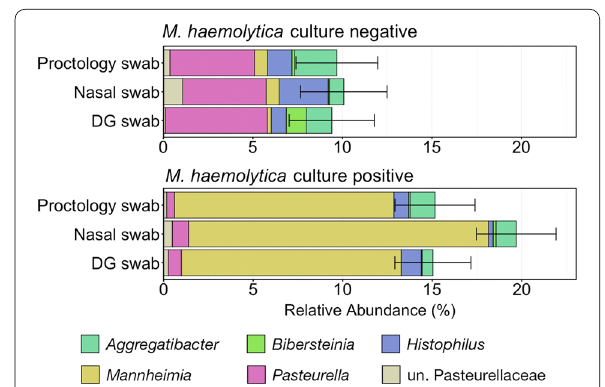
Fig. 10 Bar plot showing the relative abundances among all classified taxa for five Pasteurellaceae genera and unassigned Pasteurellaceae ASVs within M. haemolytica culture-negative and culture-positive animals, as collected with DG swabs, nasal swabs, or proctology swabs. Error bars demonstrate the standard error of the mean relative abundance of Pasteurellaceae. The six most abundant genera across all samples are displayed in the legend. Abbreviations: un.,